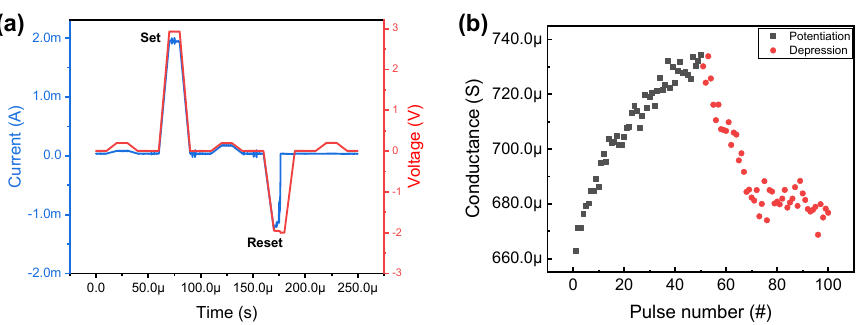
Figure 4. ( a ) Set and reset transient characteristics including set pulse, reset pulse, and read pulses; ( b ) Potentiation and depression curve as a synaptic device.